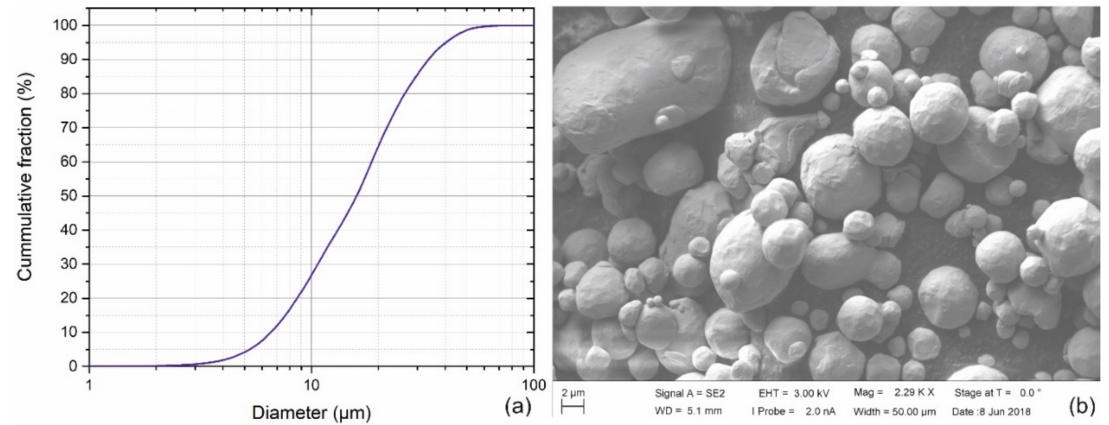
Figure 1. ( a ) Particle size distribution measured by laser scattering and ( b ) shape of copper powder observed by scanning electron